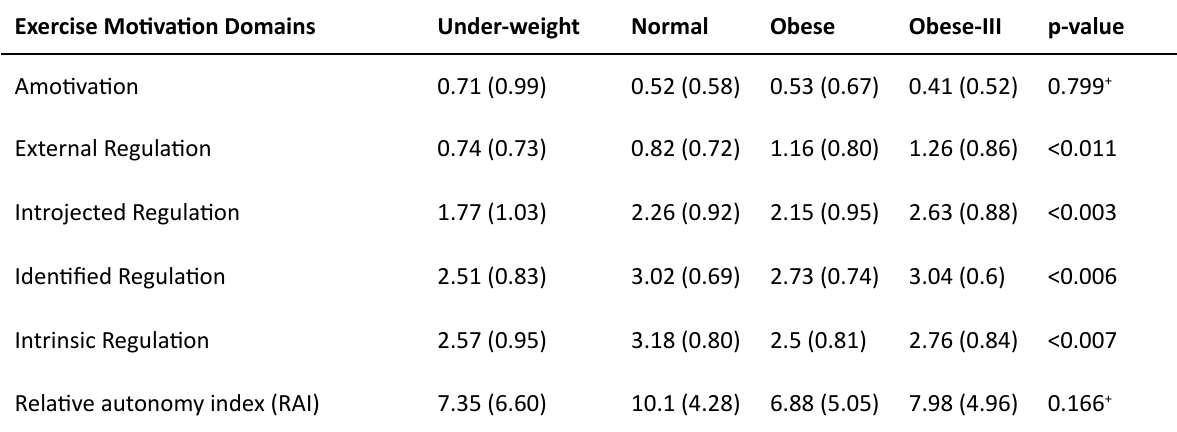
Table 2. Mean (SD) Score and ANOVA of Exercise Motivation Domains Exercise Motivation